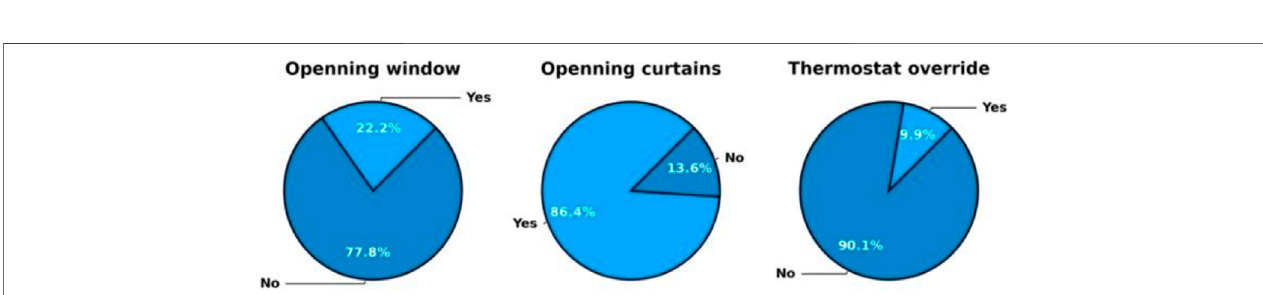
FIGURE 11 | Human interaction with of fi ce windows, blinds/curtains, and